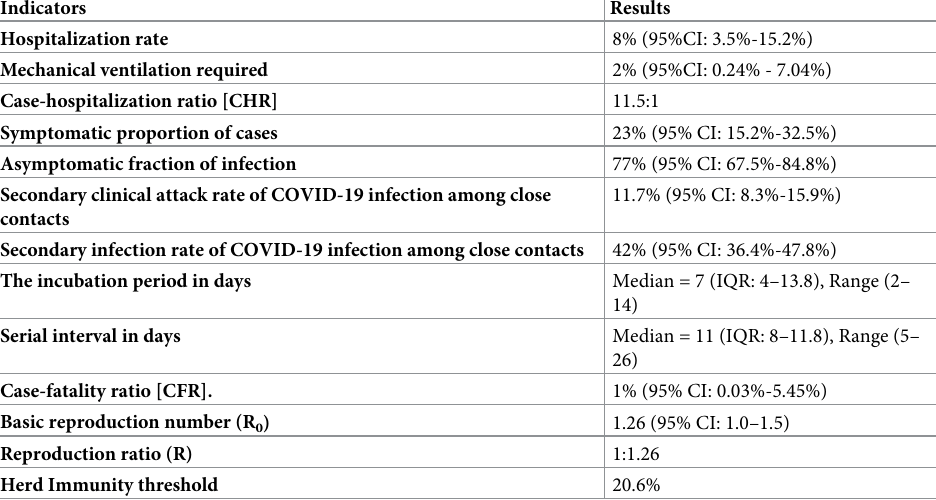
Table 2. Clinical and epidemiological indicators for the cases and close contacts investigation in Ethiopia, 15 May to 15 June 2020.